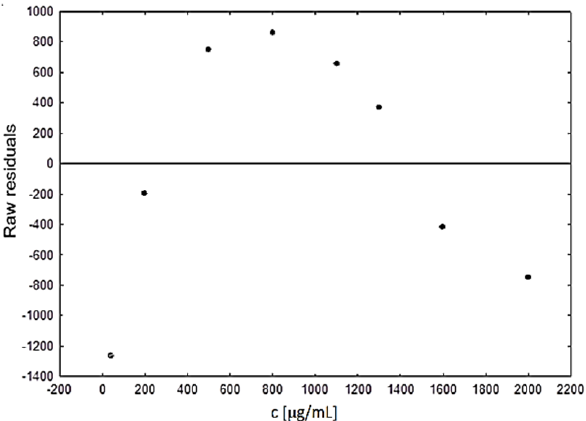
Figure 3. The scatter plot of raw residuals against the predicted values of the independent